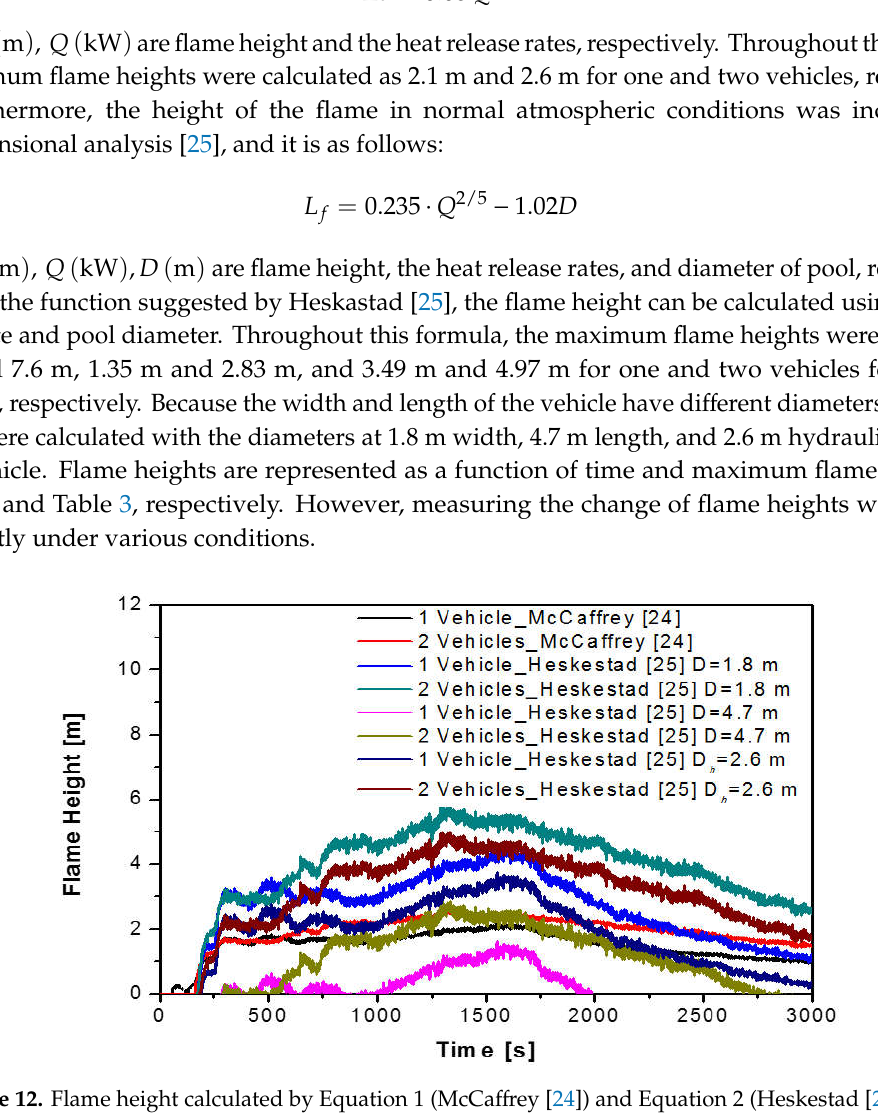
Figure 12. Flame height calculated by Equation 1 (McCaffrey [24]) and Equation 2 (Heskestad [25]) for varying diameter as a function of